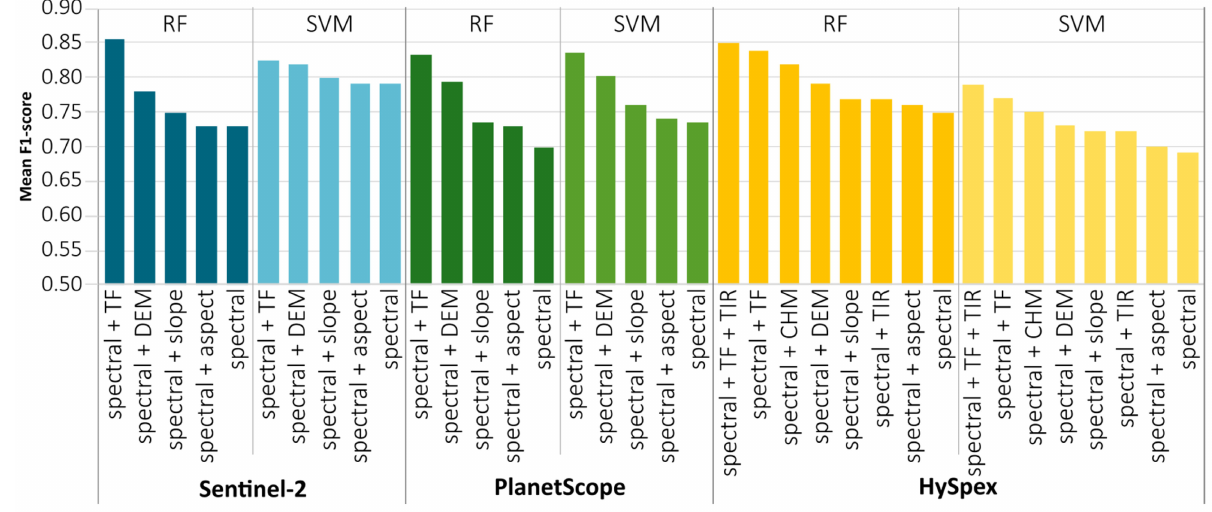
Figure 7. Impact of variables on improvement in mean F1-score values for 100 iterations. Explanation: TF, topographic features (digital elevation model, canopy height model, and slope and aspect maps); TIR, thermal